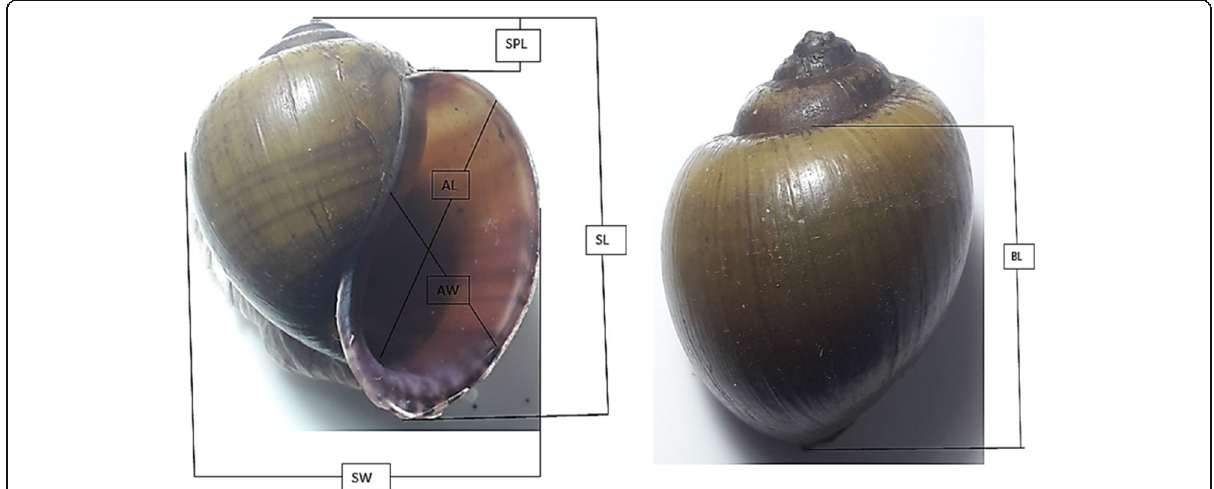
Fig. 1 Schematic diagram of apertural ( a ) and abapertural ( b ) view of shell of Pila globosa with parameters selected for morphometric